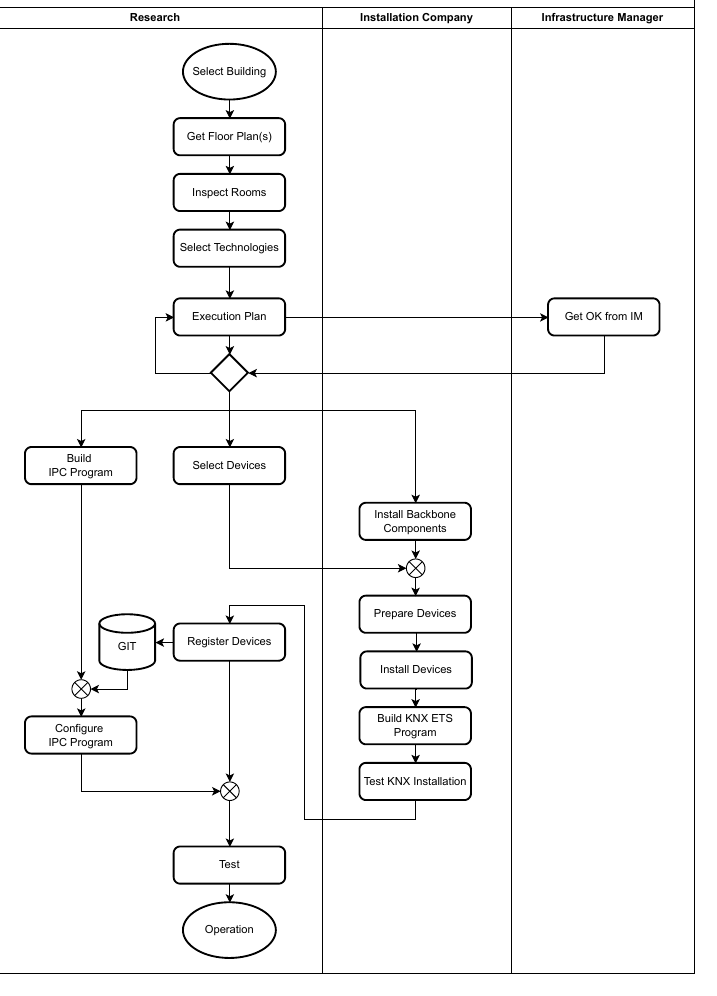
Figure 7. Proposed workflow for the selection, provisioning, and installation of devices that use the KNX